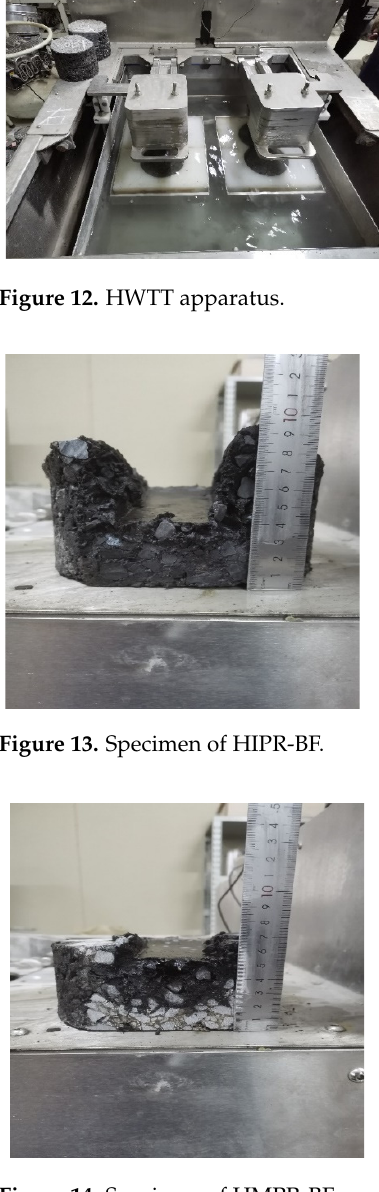
Figure 11. SGC specimen.